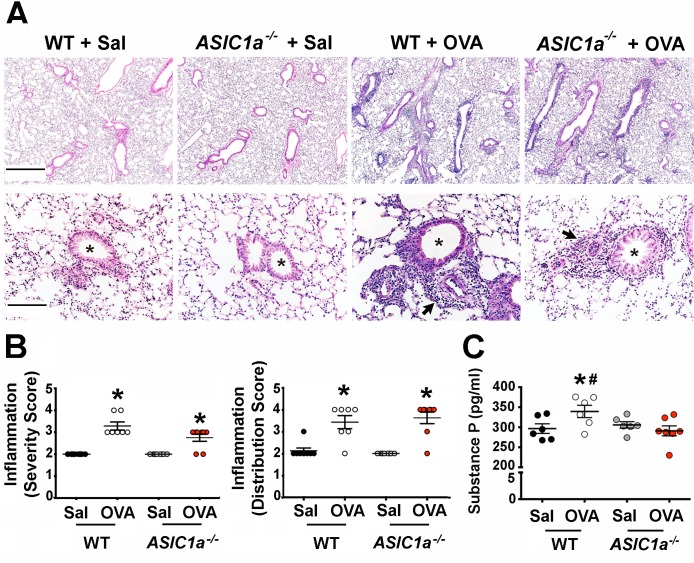
OVA-sensitization induces similar bronchovascular inflammation in wild-type and ASIC1a-/- mice.A) Representative hematoxylin and eosin staining of mouse lung sections. Asterisks indicate airways; arrows indicate examples of bronchovascular inflammation. Scale bar for top panels indicates 700 μm; for lower panels bar indicates 140 μm. B) Bronchovascular inflammation score. Bronchovascular inflammation severity was scored as follows: 1, within normal limits; 2, focal solitary cells with uncommon aggregates; 3, multifocal nominal to moderate sized aggregates; 4, moderate to high cellularity, multifocal large cellular aggregates that may be expansive into adjacent tissues. The following scores were assigned for bronchovascular inflammation distribution: 1, within normal limits; 2, minor to localized aggregates, <33% of lung; 3, multifocal aggregates, 33–66% of lung; 4, aggregates coalescing to widespread, >66% of lung. For severity score: WT + Sal vs. WT + OVA, * indicates p = 0.0002; for ASIC1a-/- + Sal vs. ASIC1a-/- + OVA, * indicates p = 0.007. For distribution score: WT + Sal vs. WT + OVA, * indicates p = 0.005; for ASIC1a-/- + Sal vs. ASIC1a-/- + OVA, * indicates p = 0.001. C) Substance P measured by ELISA in the bronchoalveolar lavage fluid as a test of sensory nerve activity. For WT + Sal vs. WT + OVA, * indicates p = 0.05; for WT + OVA vs. ASIC1a-/- + OVA, # indicates p = 0.03. For panels B and C, each symbol indicates data from an individual mouse. Bars and whiskers indicate mean±SEM. Abbreviations: OVA, ovalbumin; Sal, saline; WT, wild-type; ASIC, acid-sensing ion channel.